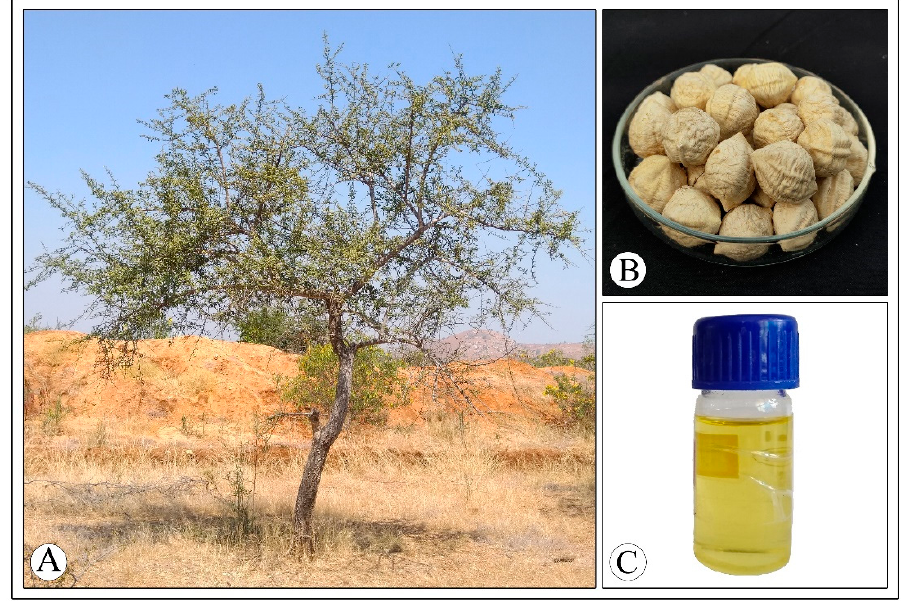
Figure 1. ( A ) Habit of Balanites roxburghii ; ( B ) Seed kernel; ( C ) Seed oil.